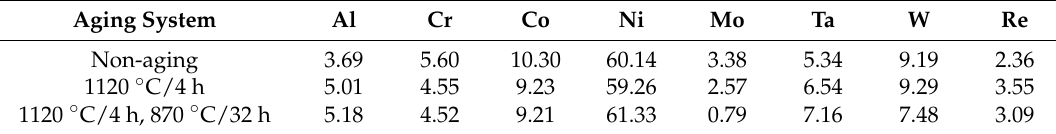
Table 6. Constituents (mass fraction) of the precipitation phases under three aging systems.